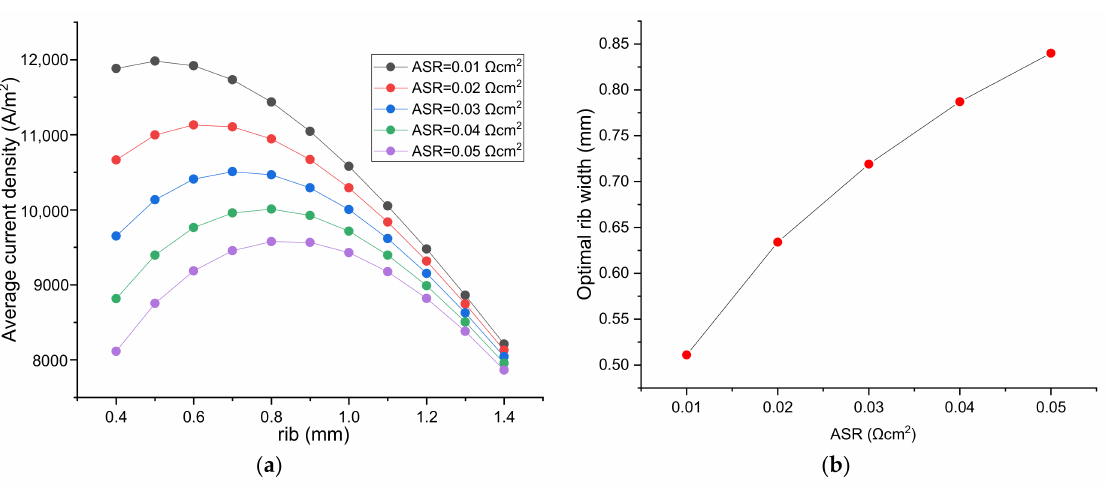
Figure 4. ( a ) The e ff ect of ASR of the H 2 electrode and rib interface on SOEC performance and the optimized rib width; ( b ) The relationship between optimal rib width and